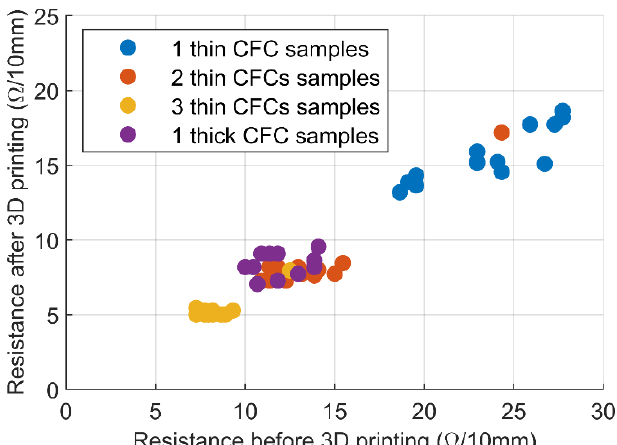
Figure 3. CFC layers’ resistance per 10 mm before and after the 3D printing process. The sample series contained 15 parallel samples.